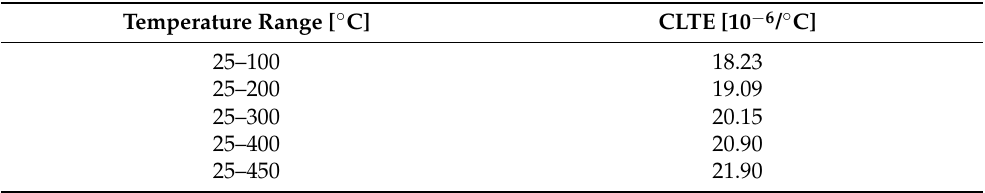
Table 3. Results of measuring the coefficient of linear thermal expansion of the 5-mm diameter composite